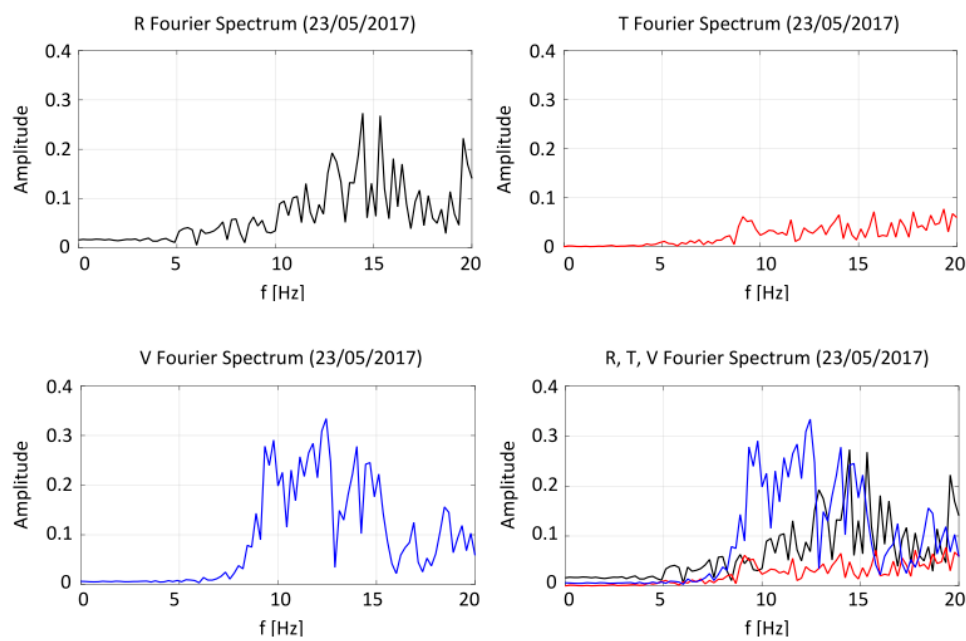
Figure 9. Fourier spectra derived by the acceleration time histories coming from all the recordings on 23 May 2017.